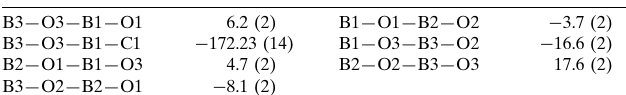
Selected torsion angles ( (cid:1)